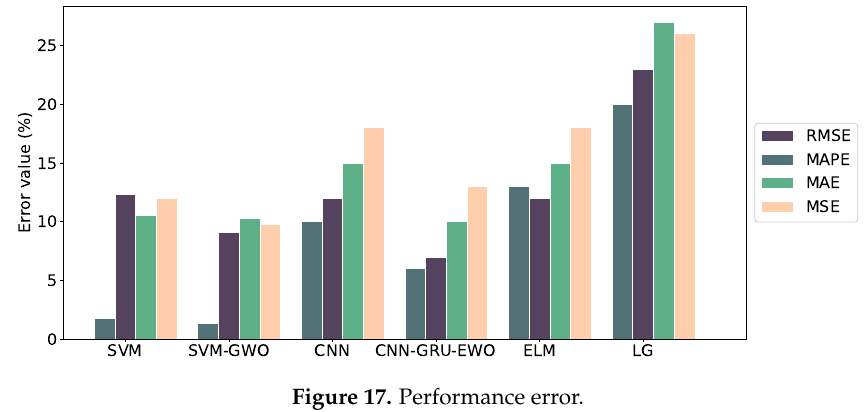
Figure 17. Performance